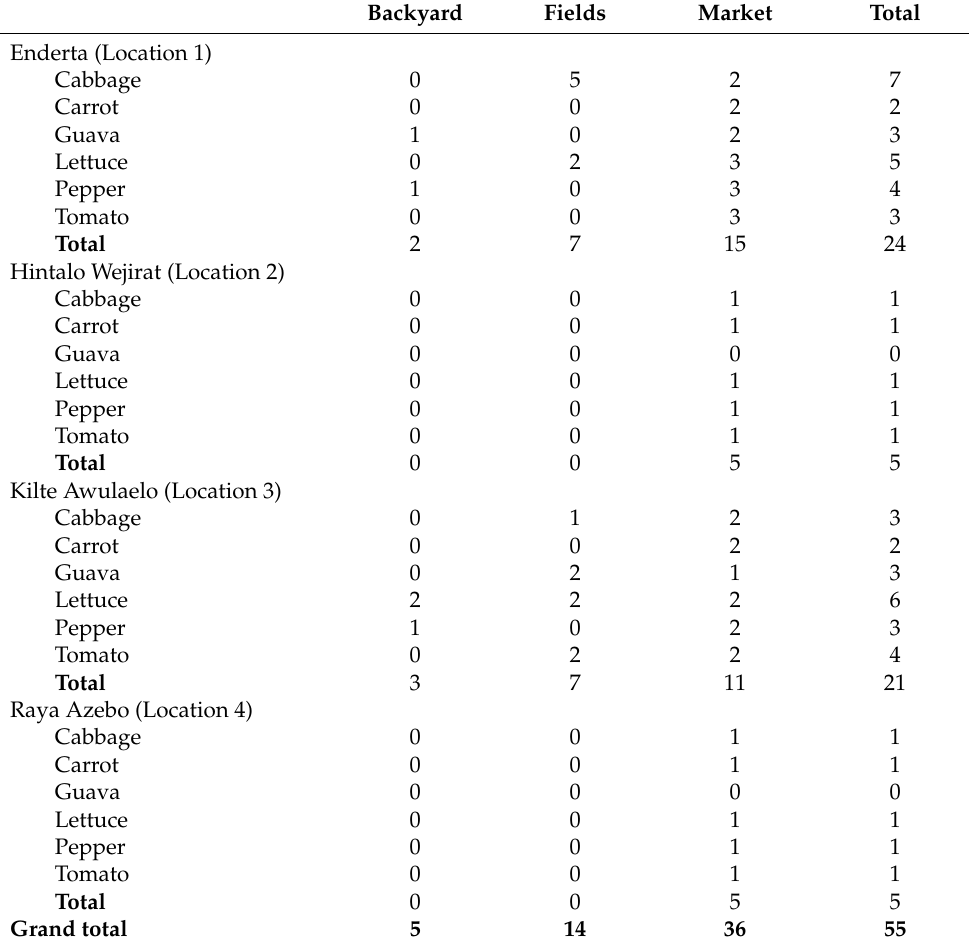
Table 1. Sources of vegetables and fruits from the four